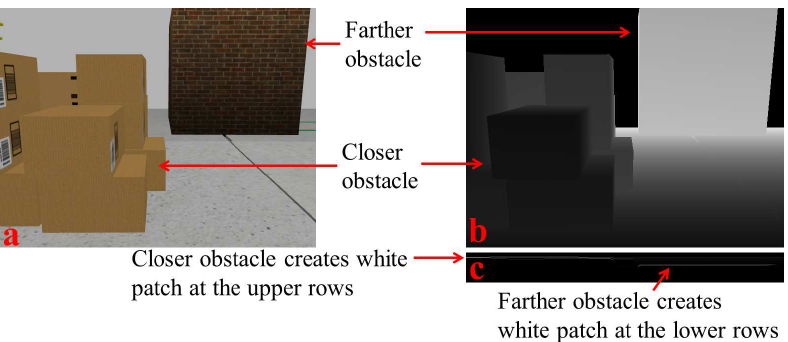
Figure 3. Representation of obstacles in the u-depth map. ( a ) A sample RGB snapshot in a simulated environment under Gazebo [33]. ( b ) Corresponding depth image, where a smaller depth is repre- sented with lower intensity. ( c ) Corresponding u-depth map, in which the white patch position is comparatively at the smaller (or upper) row index for the closer